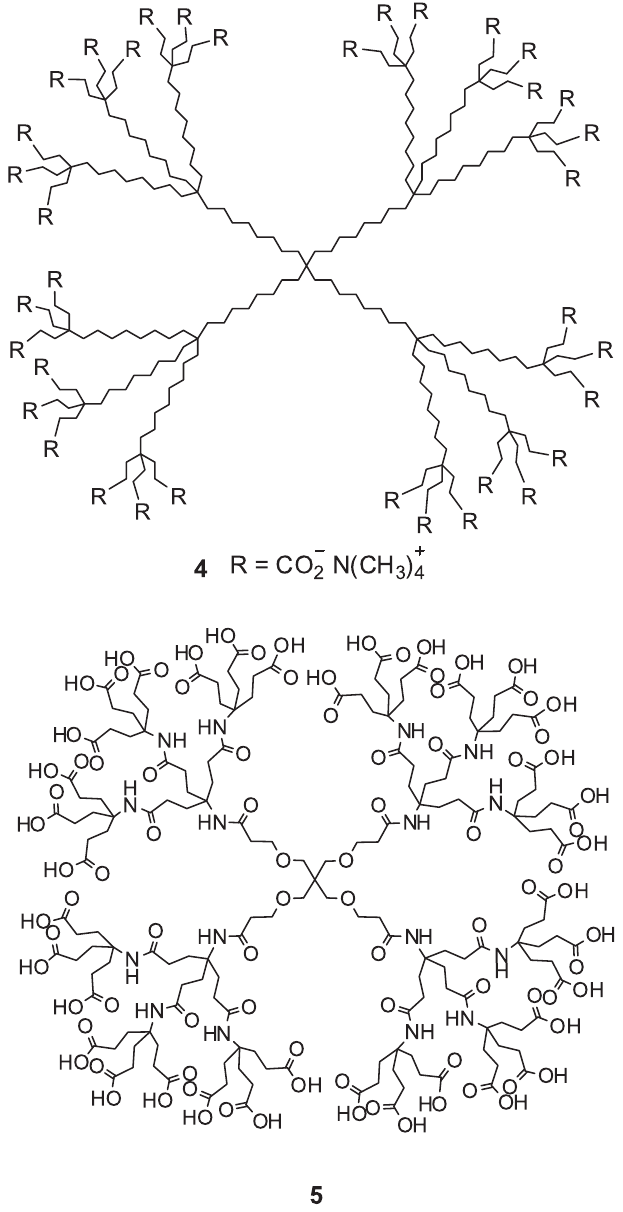
FIGURE 4 – Unimolecular micelles with an all-saturated, hydrocarbon ( 4 ) and amide-based ( 5 ) interiors [Newkome,